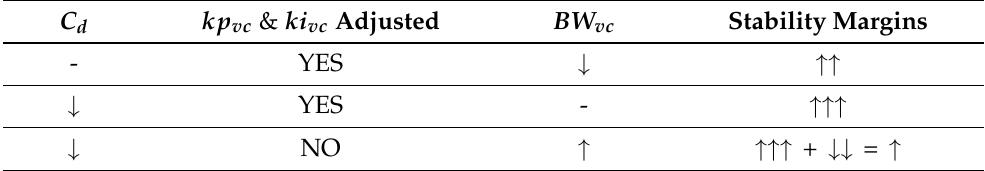
Table 4. Impact of very small variations of voltage controller and DC-link capacitance on LFO stability. Arrows ↑ stands for increments and ↓ stands for decrements.